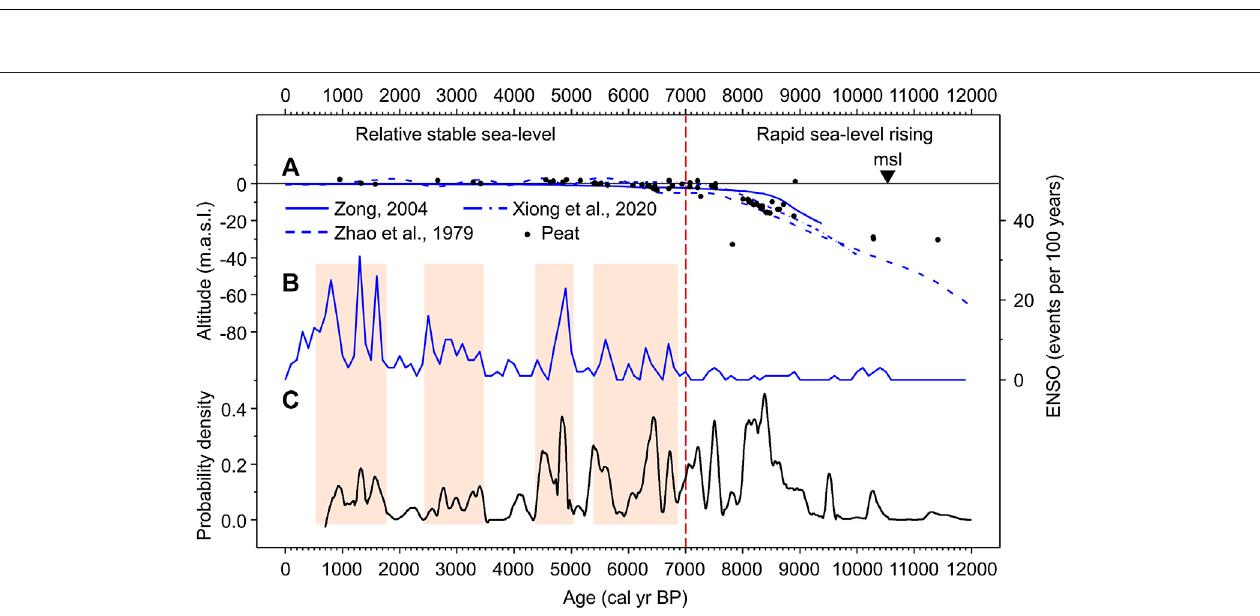
FIGURE8| Environmentbackgroundsofpeatformation. (A) Sea-levelcurvesofeastChina(Zhaoetal.,1979;Zong,2004;Xiongetal.,2020)andaltitudeofpeatin thisstudy. (B) ElNiño-SouthernOscillation (ENSO)eventsper100 years(Moyetal.,2002). (C) SPDofradiocarbondatesofpeatinthelowerYangtzeregion(200-point- smoothing